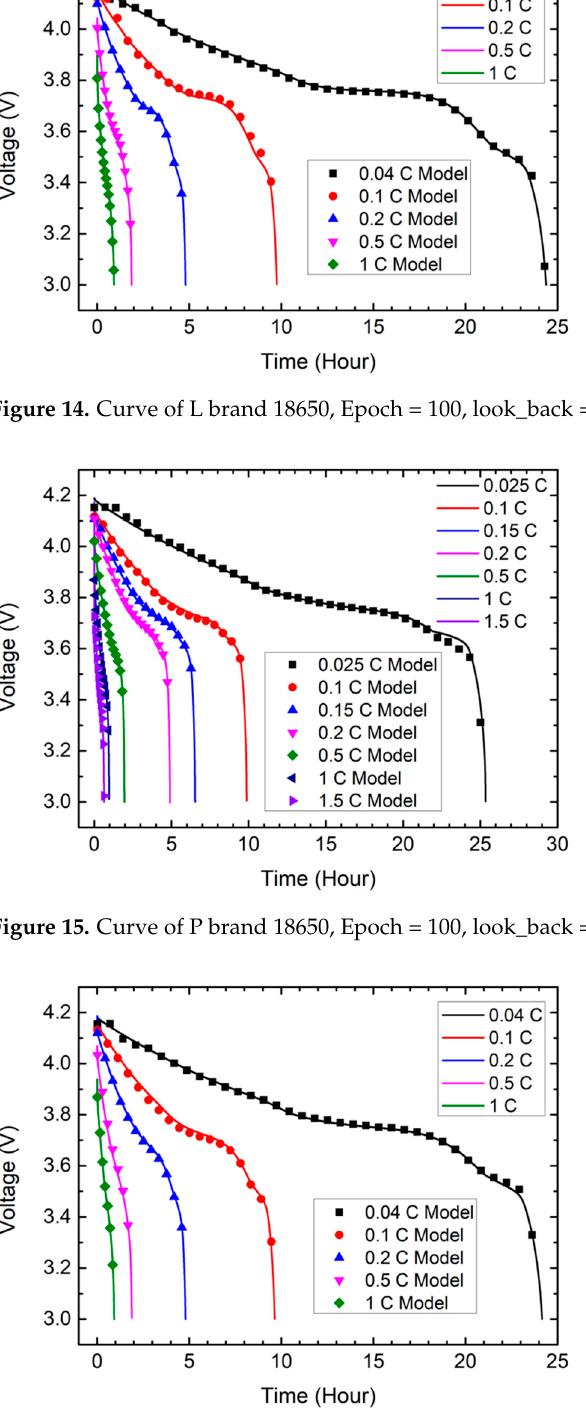
Figure 16. Curve of S brand 18650, Epoch = 100, look_back = 10.